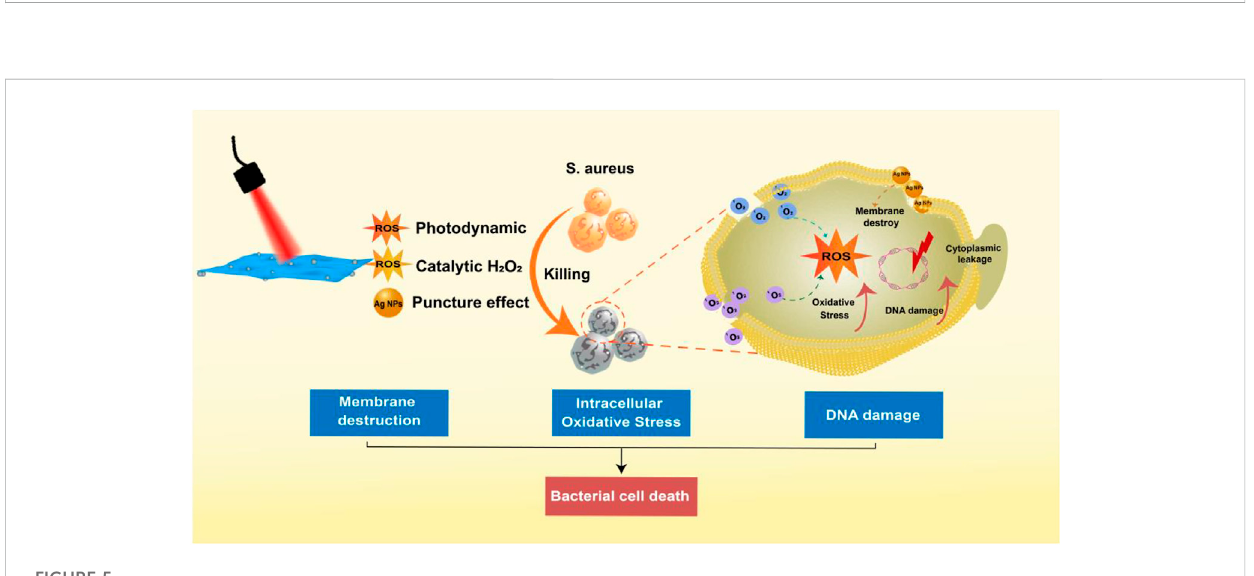
FIGURE 5 The multi-level synergistic antibacterial mechanism of MoS 2 /Ag nanosheets.